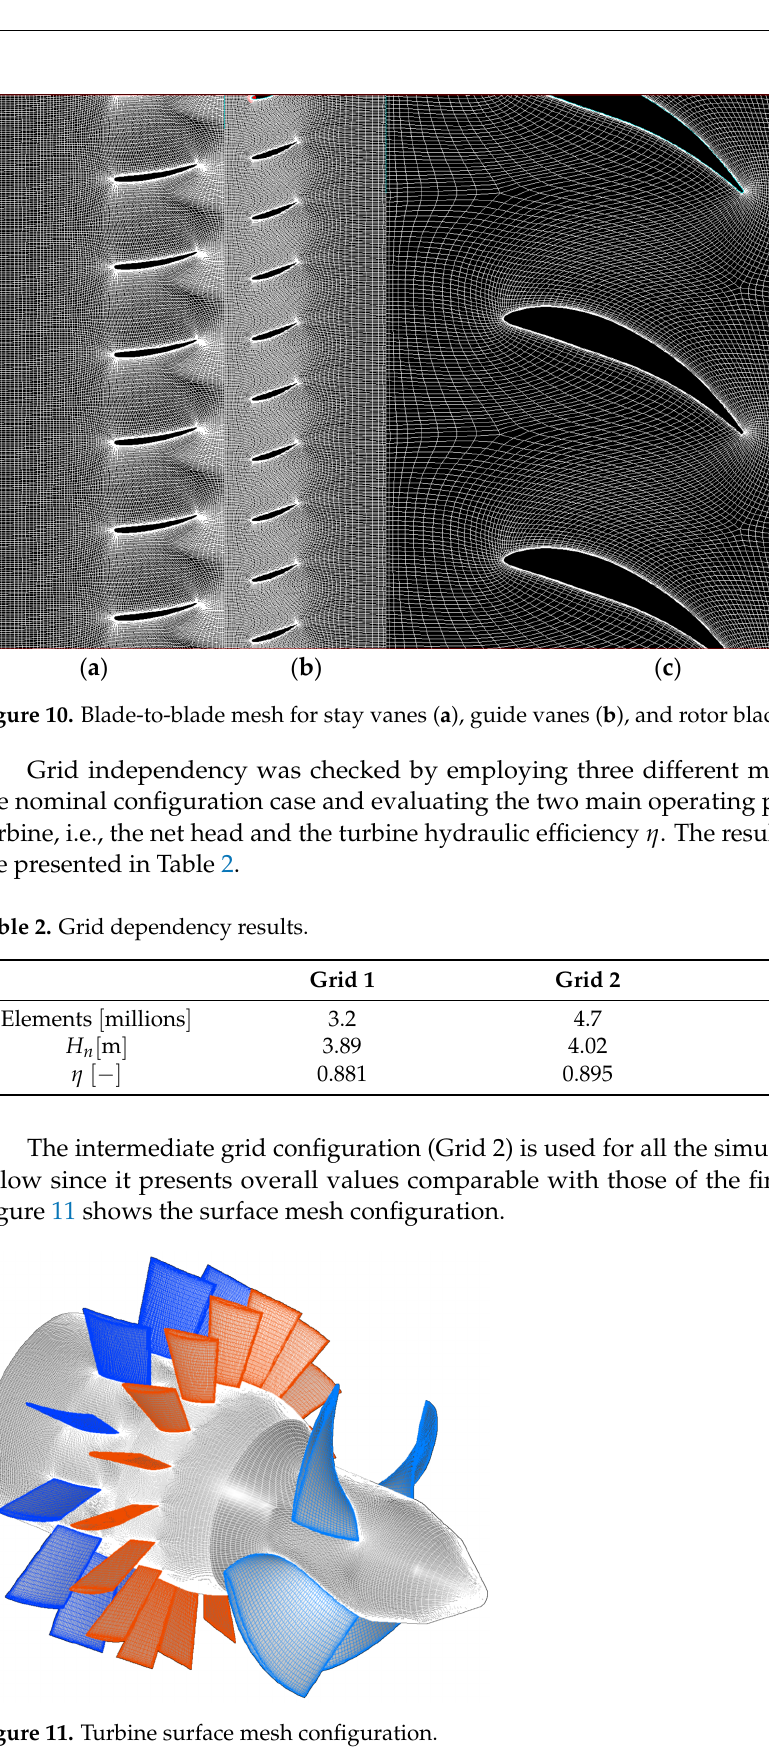
Figure 11. Turbine surface mesh configuration.